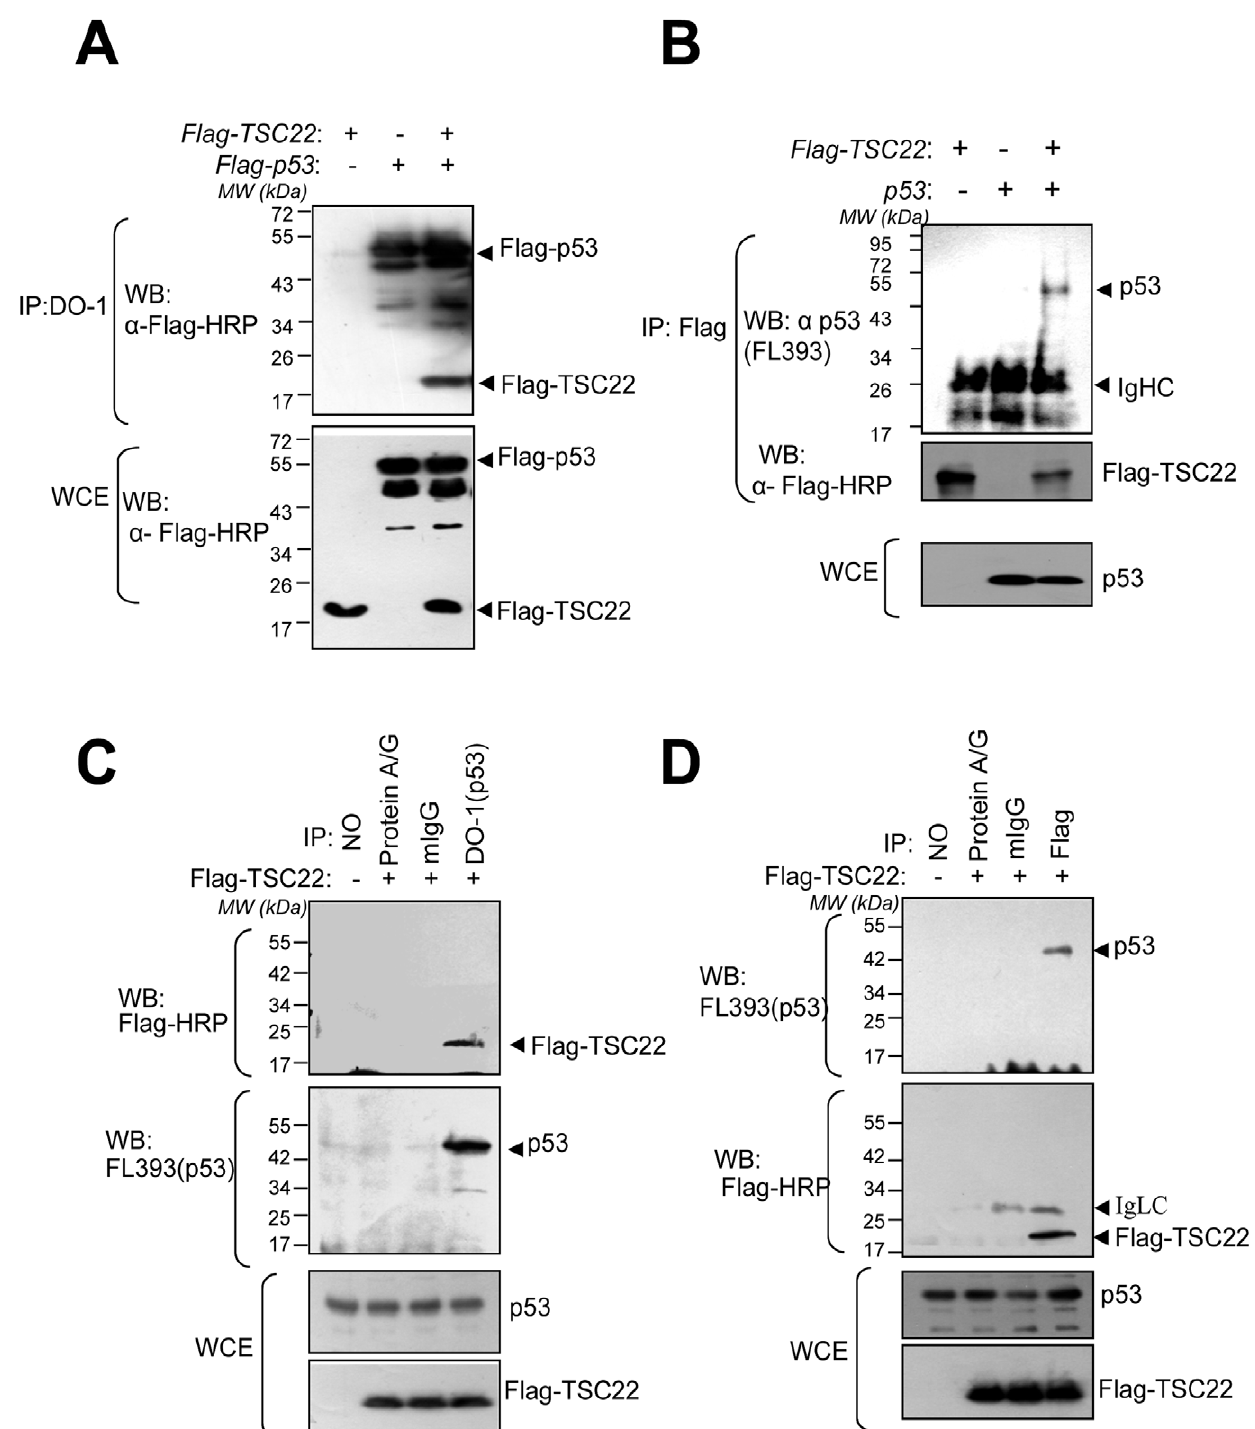
Figure 3. TSC22 interacts with p53 invivo. (A–B) TSC22 interacts with ectopic p53. Ectopically expressed TSC-22 interacts with ectopically expressed p53 in H1299 cells. Two m g of Flag-TSC-22 expression vector was cotransfected with Flag-p53 expression vector (A) or a non-tagged p53 expression vector (B) into H1299 cells cultured in 100 mm plates. 48 h after transfection, cell lysates were immunoprecipitated with an anti-p53 (DO- 1) (A) or anti-Flag (B) monoclonal antibody. Immunoprecipitates were analyzed by Western blotting using an HRP-conjugated anti-Flag (A) or anti-p53 (FL393) (B) monoclonal antibody. ( C–D ) TSC-22 interacts with endogenous p53 . Ectopically expressed TSC-22 interacts with endogenous p53 in cells. HEK293 cells were transfected with 2 m g of Flag-TSC-22 plasmid for 48 h. Cell lysates were immunoprecipitated with anti-p53 (DO-1) monoclonal antibody, mouse immunoglobulin G (IgG) (C), or an anti-Flag (D) monoclonal antibody. Immunoprecipitates were analyzed with Western blotting using an HRP-conjugated anti-Flag (C) or anti-p53 (FL393) antibody.